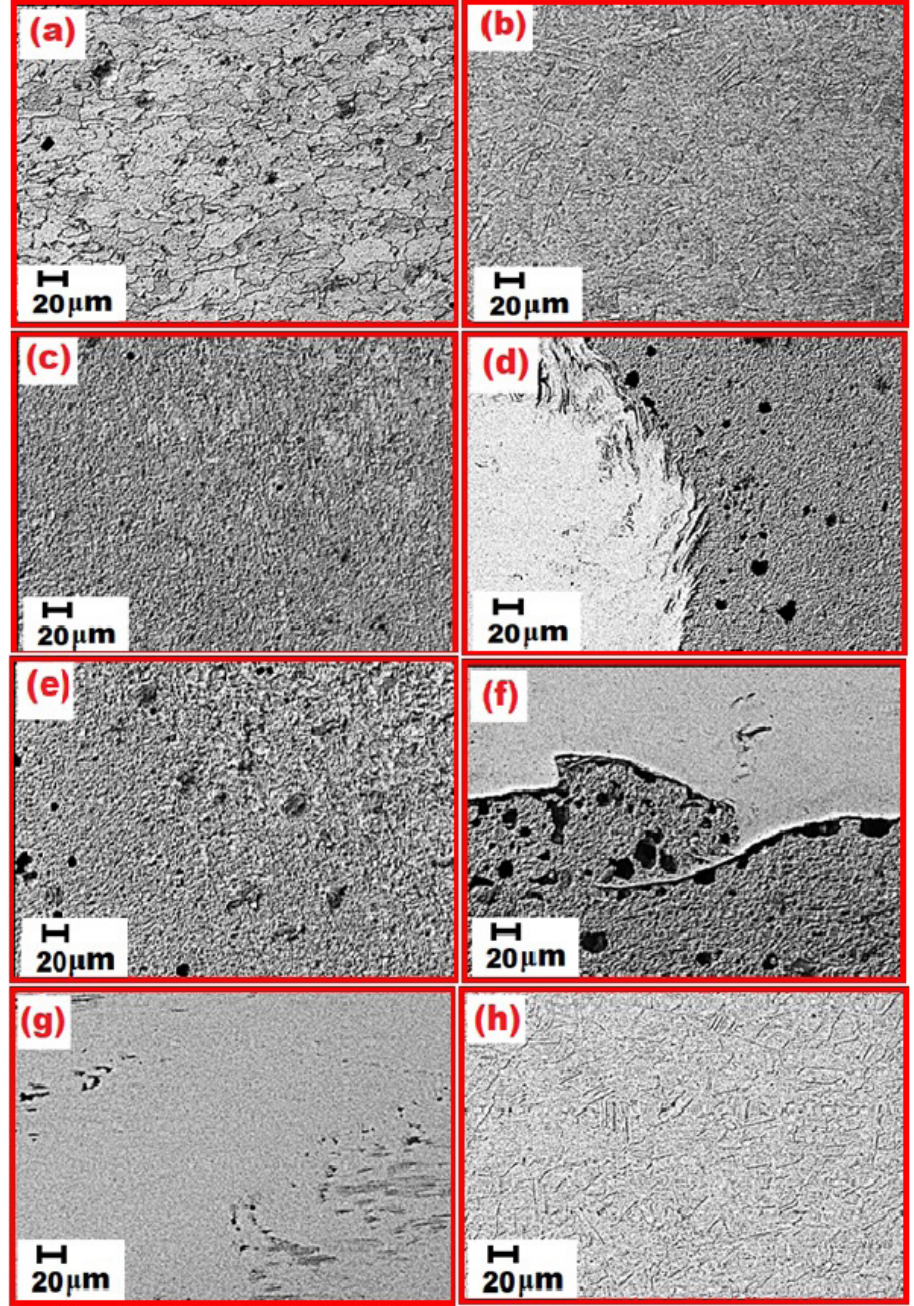
Figure 7. SEM microstructure of FSW joint of copper and LCSs; (a) parent steel, (b) Cu–parent, (c) steel nugget, (d) Cu–St nugget, (e) interface St–Cu, (f) St–Cu bottom, (g) Cu–shoulder, and (h)